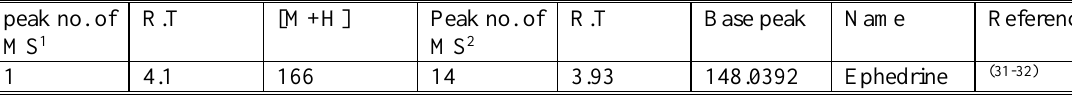
Table 5. UPLC ESI MS/MS for isolated AS2 compound peak no.